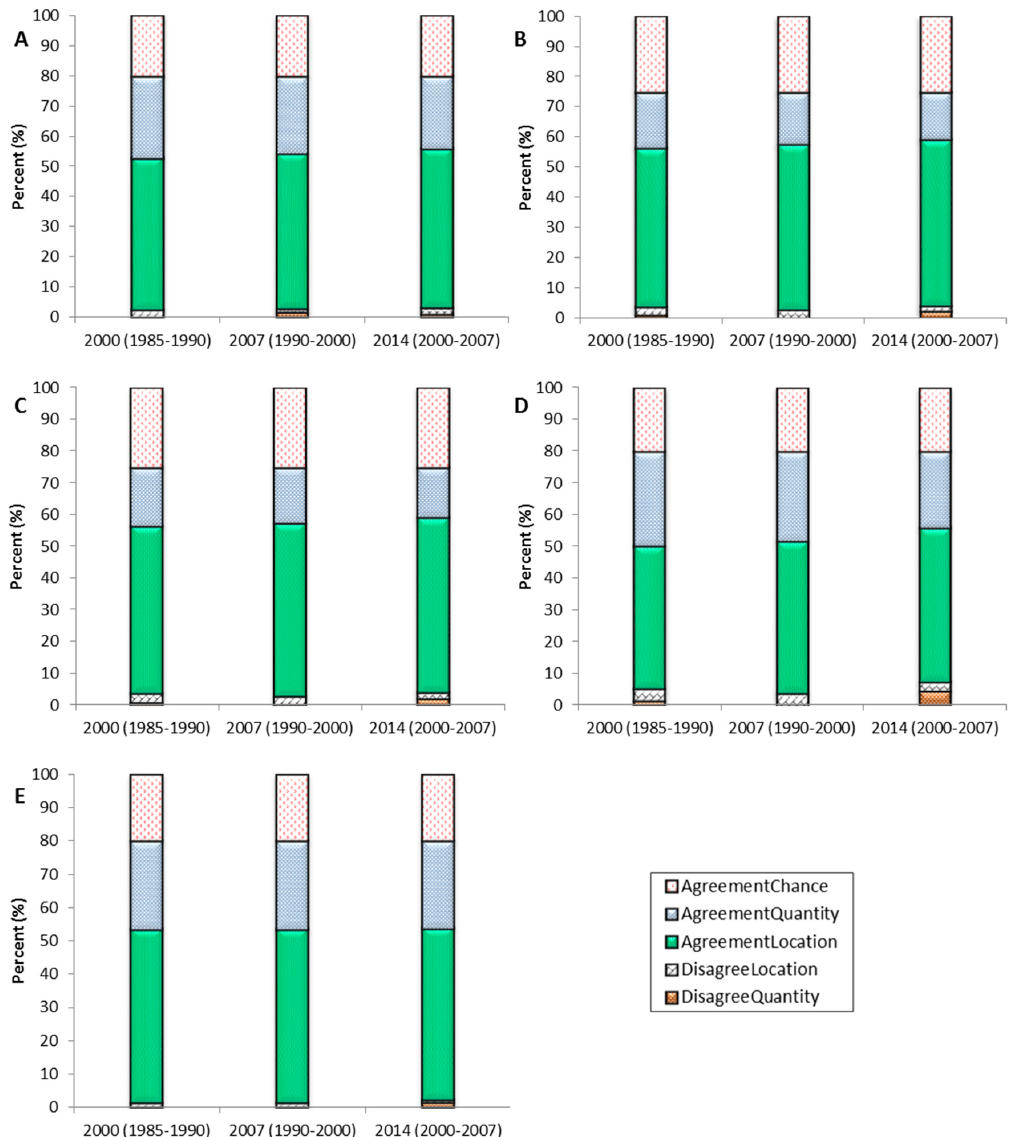
Figure 5. Validation of the MC–CA integrated model for allocation and quantity agreement for ( A ) Riyadh; ( B ) Jeddah; ( C ) Makkah; ( D ) Al-Taif; and ( E ) the Eastern Area simulations.